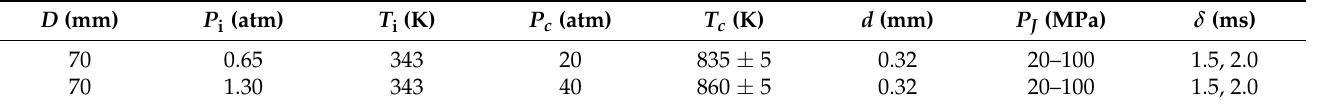
Table 2. Experimental conditions of diesel spray-wall impingement.